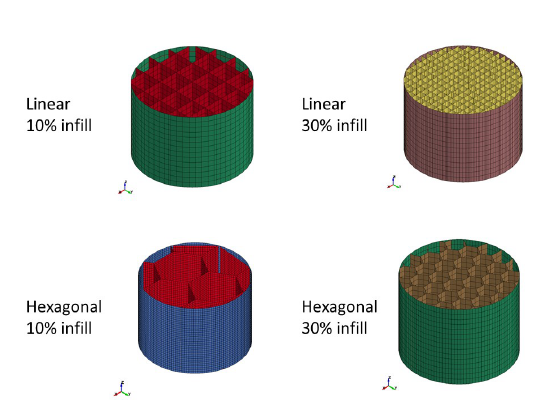
Figure 13. Isomeric views of virtual 3D printed specimen